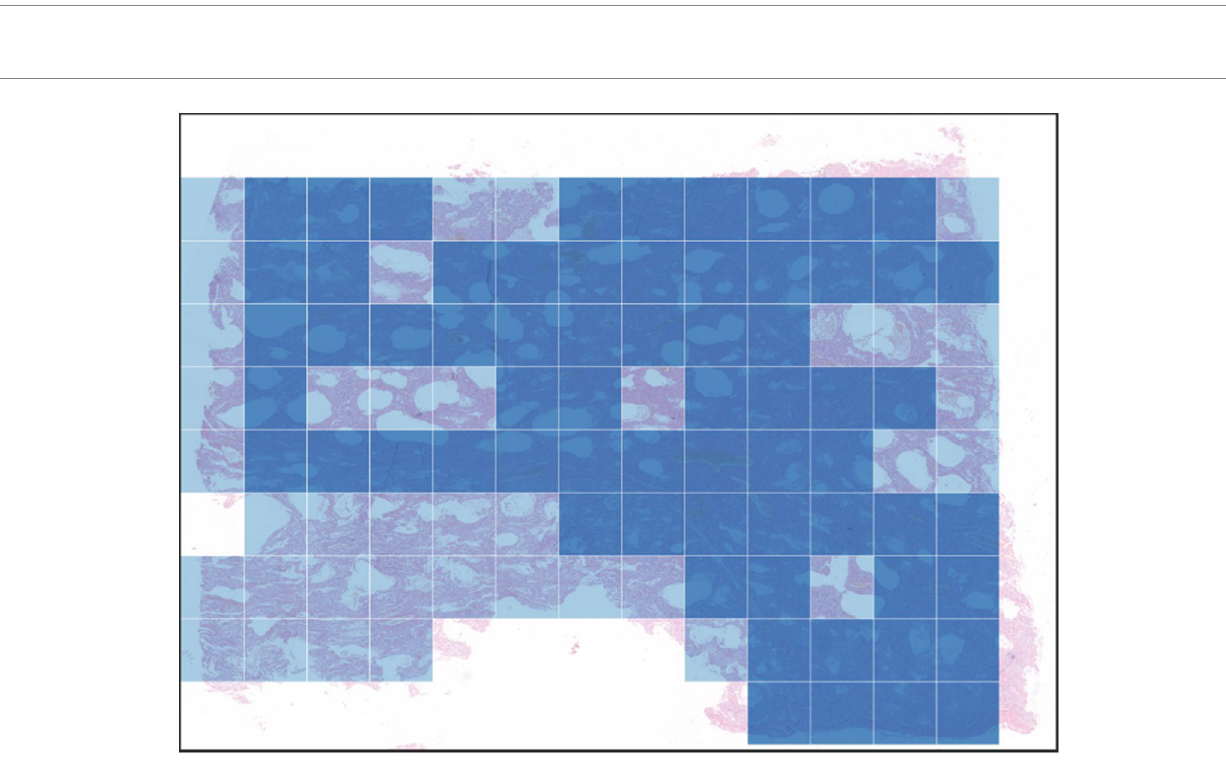
FIGURE 6 Global visualization